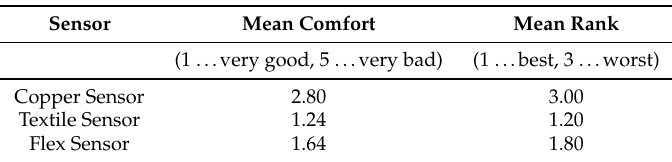
Table 5. Wearing comfort of different sensor